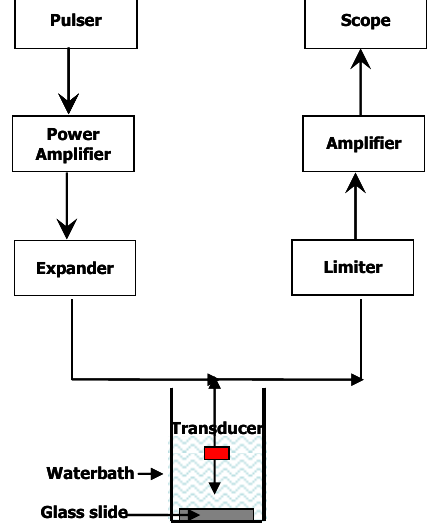
Figure 7. Experimental imaging